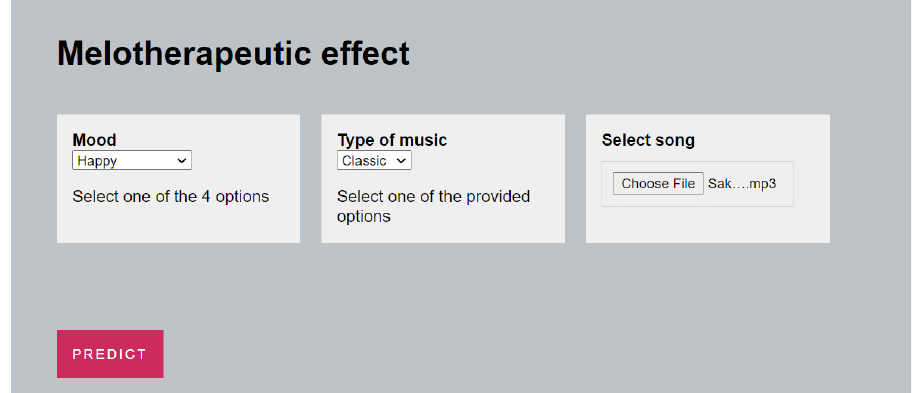
Figure 8. ClassificationWeb Application UI.